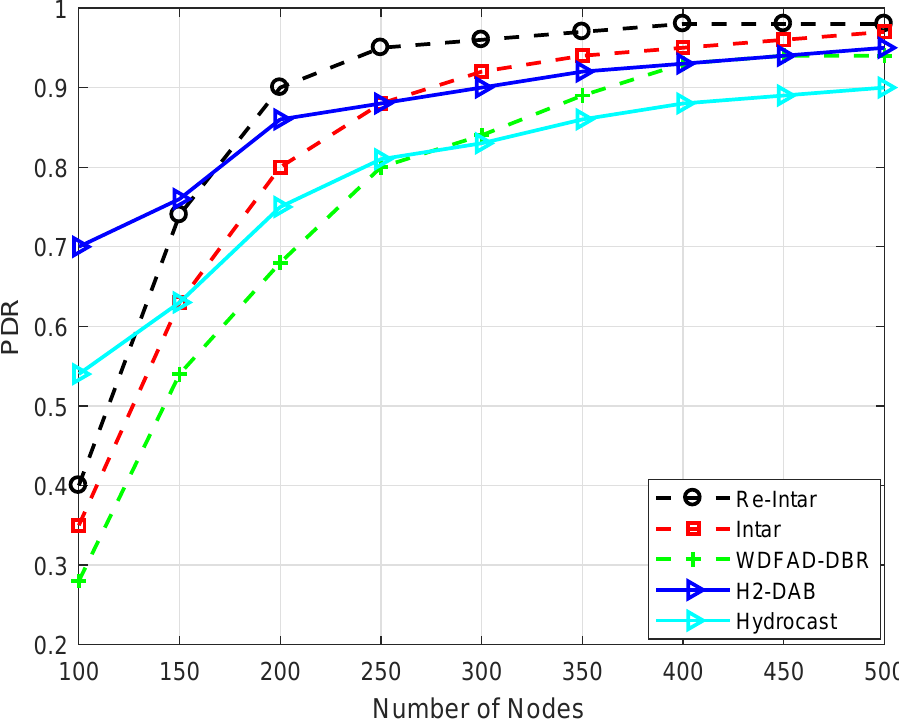
Figure 4. PDR of the existing and proposed protocols with varying number of